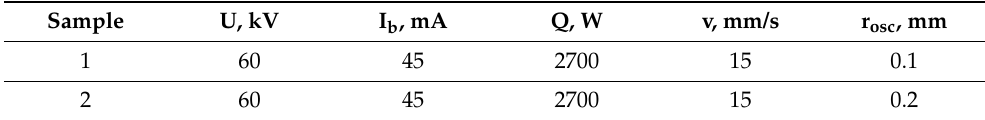
Table 1. Technological parameters of EBW of Cu/Al6082T6.